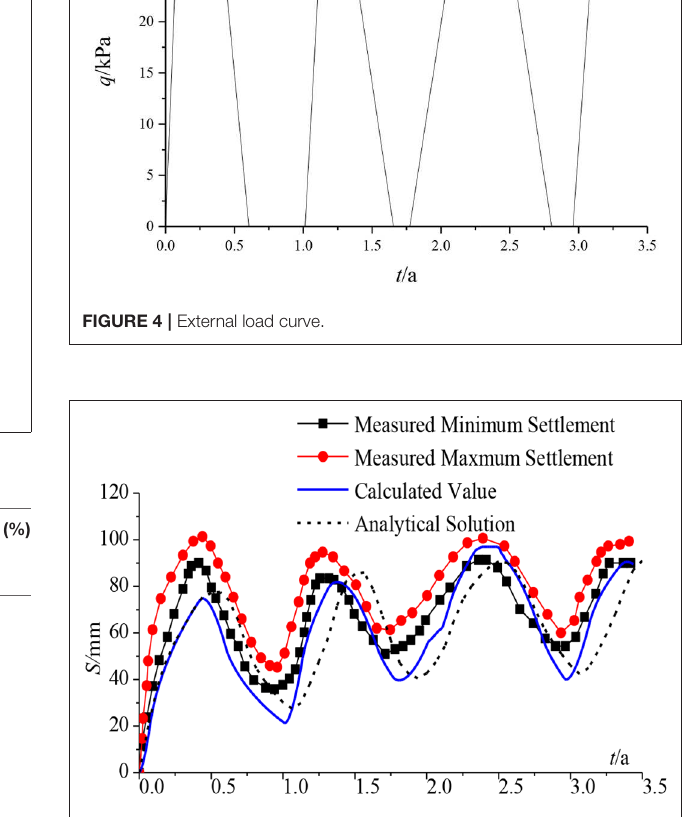
FIGURE 5 | Ground settlement